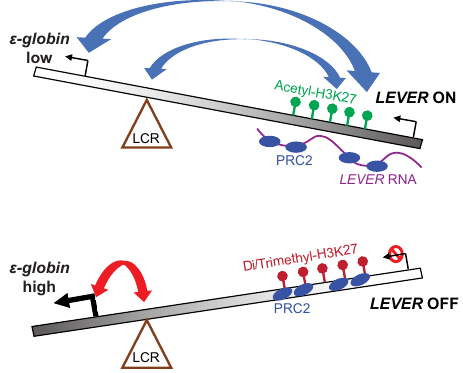
Fig. 6 The proposed model of LEVER RNA regulating ε -globin transcription. Top diagram: LEVER RNA sequesters and antagonizes PRC2 in cis. This maintains the accessibility of the LEVER locus and facilitates its chromatin interaction with the ε -globin promoter and LCR region, which negatively regulates ε -globin transcription. Bottom diagram: When LEVER is silenced, the LCR can now interact with the ε -globin promoter to induce ε -globin